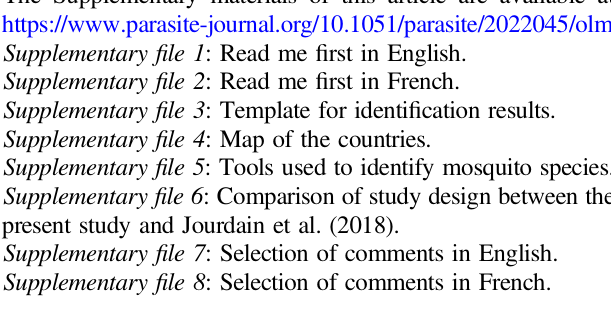
Supplementary fi le 1 : Read me fi rst in English. Supplementary fi le 2 : Read me fi rst in French. Supplementary fi le 3 : Template for identi fi cation results. Supplementary fi le 4 : Map of the countries. Supplementary fi le 5 : Tools used to identify mosquito species. Supplementary fi le 6 : Comparison of study design between the present study and Jourdain et al. (2018). Supplementary fi le 7 : Selection of comments in English. Supplementary fi le 8 : Selection of comments in French.